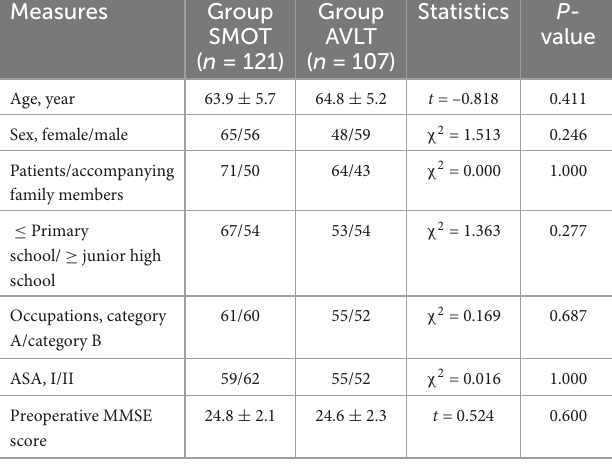
TABLE 3 Comparison of the SMOT to AVLT first